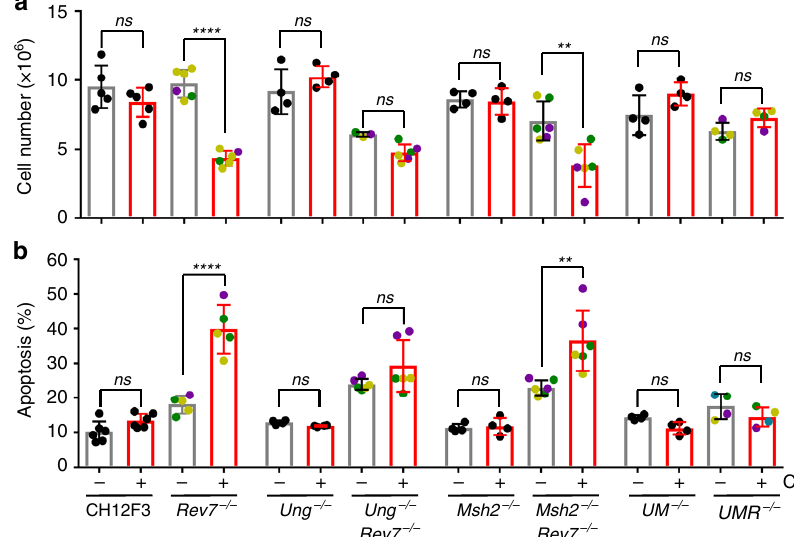
Fig. 6 B-cell death depends on UNG-processed AID lesions. Cell numbers ( a ) and percentage of apoptotic population ( b ) with( + )/without( − ) cytokine stimulation (CIT) at Day 3 are showed for indicated genotypes. UM − / − : Ung − / − Msh2 − / − , UMR − / − : Ung − / − Msh2 − / − Rev7 − / − . Colored dots indicate individual clones. In a , n = 5 for parental CH12F3 cells; n = 6 for Rev7 − / − , Ung − / − Rev7 − / − (with CIT) and Msh2 − / − Rev7 − / − ; n = 3 for Ung − / − Rev7 − / − (without CIT); n = 4 for the other genotypes. In b , n = 6 for parental CH12F3 cells, Ung − / − Rev7 − / − and Msh2 − / − Rev7 − / − ; n = 5 for Rev7 − / − ; n = 4 for the other genotypes. Three independent clones for each genotype were assayed, and n represents independent experiments. Data are represented as mean ± SD. One-way ANOVA followed by Dunnett ’ s multiple comparisons test was performed for all panels. **** p < 0.0001, *** p < 0.001, ** p < 0.01, ns: p > 0.05. P - values and sample sizes are provided in Supplementary Table 2. Source data are provided as a Source Data fi